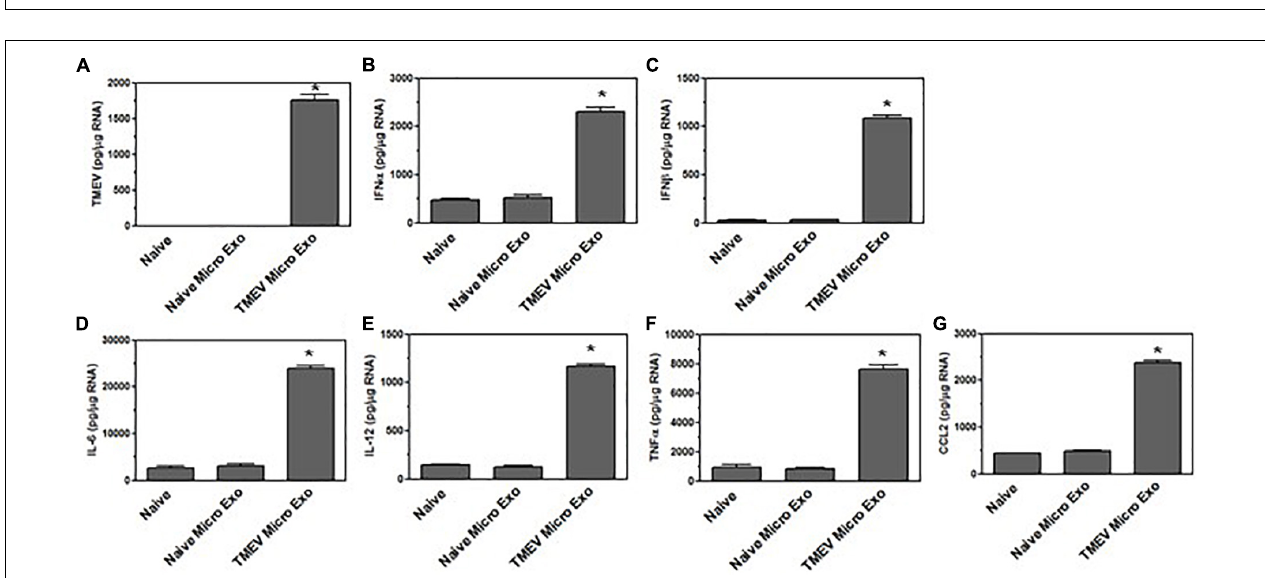
FIGURE 5 | Exosomes from TMEV-infected microglia activate bystander neurons. Exosomes were isolated from uninfected (naïve) microglia or TMEV-infected microglia and placed on naive neurons for 24 h. Neurons were lysed, RNA isolated, converted to cDNA, and analyzed by real time PCR for expression of TMEV (A) , IFN α (B) , IFN β (C) , IL-6 (D) , IL-12 (E) , TNF α (F) , and CCL2 (G) . Significant difference was determined by the one way ANOVA and Bonferroni’s multiple comparison test (* p < 0.001) based on unstimulated microglia. These are representative graphs from one experiment of three independent repeated experiments.